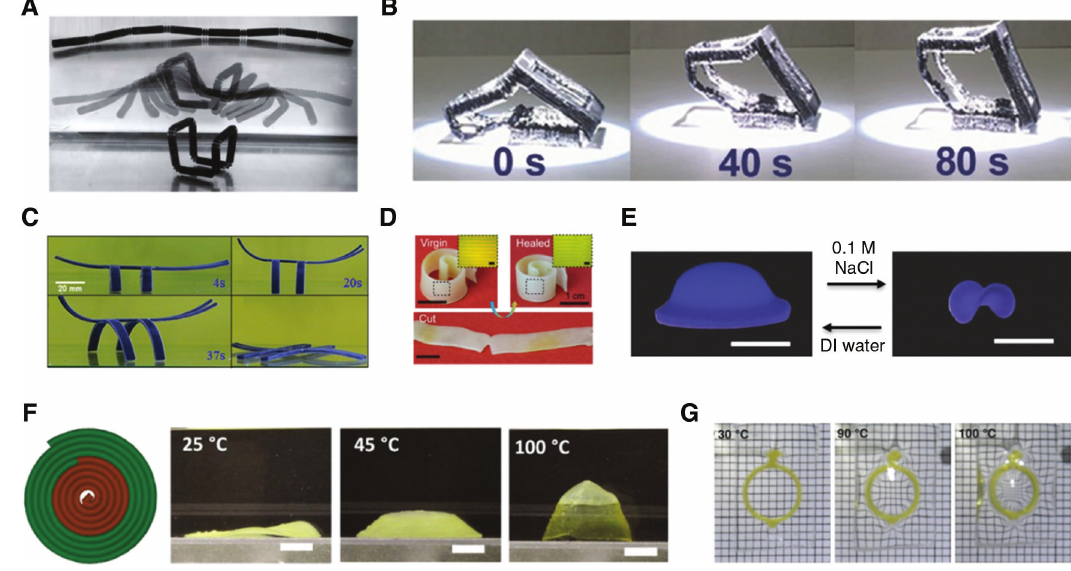
Figure 4: 4D printing with smart